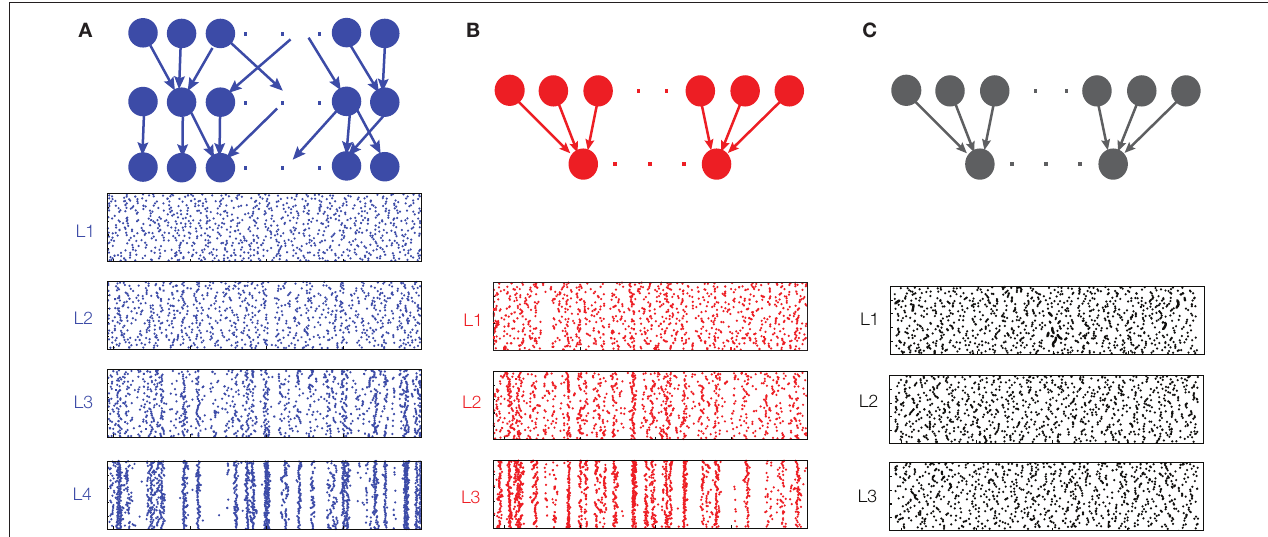
Figure 3 | Development of synchrony in feedforward networks. (A) the first layer, r 1 Spike rasters from a simulation of a randomly connected feedforward network. Each cell receives n = 1400 excitatory and n = 600 inhibitory e i inputs. In addition, two cells in a layer share, on average, a proportion p = 0.05 of their inputs. Each cell in layer 1 receives an independent Poisson excitatory input, so that outputs from the first layer are uncorrelated. (B) A feedforward network with no overlap. Each cell receives the same number of inputs as in (A) , but there are no shared inputs ( p = 0). Correlated inputs are introduced to